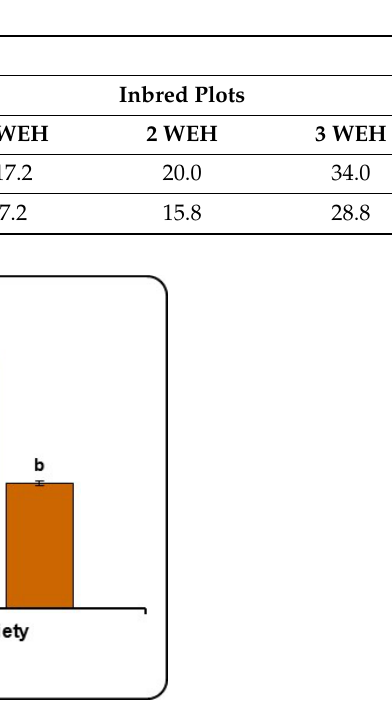
Table 3. Loss in grain yield (in %) associated with different densities of white earheads and rice cultivation methods.